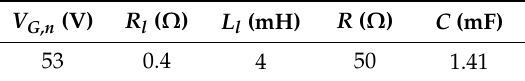
Table 1. Parameters of the equivalent